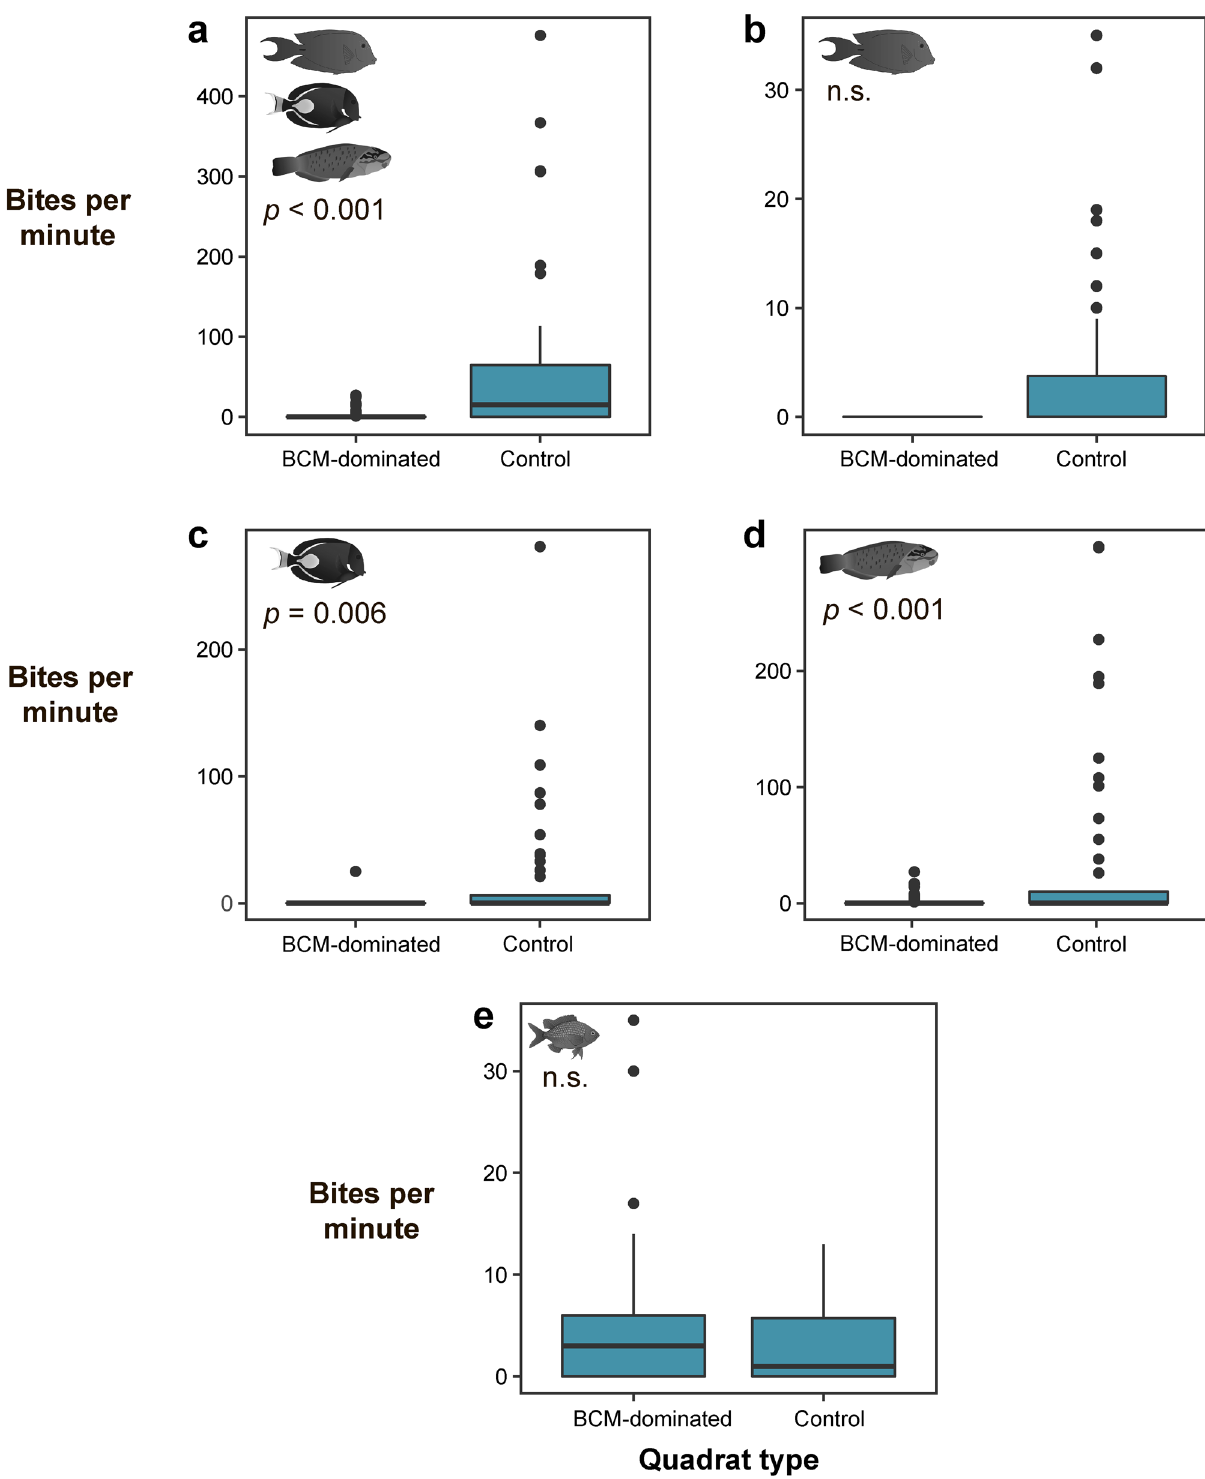
Figure 3. Boxplots representing bite rates measured in quadrats dominated by benthic cyanobacterial mats (‘BCM-dominated’) or devoid of mats (‘Control’). Plots represent bites on the substrate observed for: ( a ) all herbivorous functional groups combined (i.e. sum of b–d), ( b ) detritivores, ( c ) grazers, ( d ) scrapers, and ( e ) damselfishes. Significance level as determined by zero-inflated generalised linear mixed effect models is shown for each graph; n.s. = not significant. Note the different scales on the